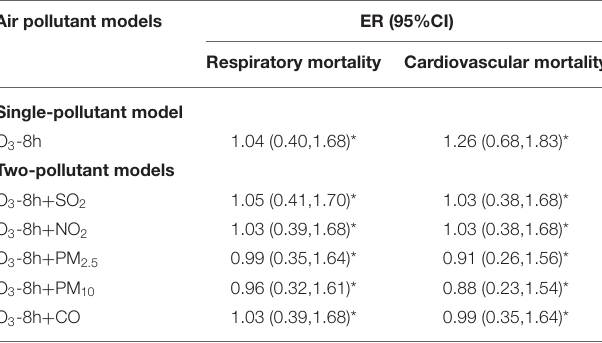
TABLE 3 | The excess risk (95%CI) of air pollutant associated with 10 µ g/m 3 increase of O 3 -8h concentration in the double-pollutant